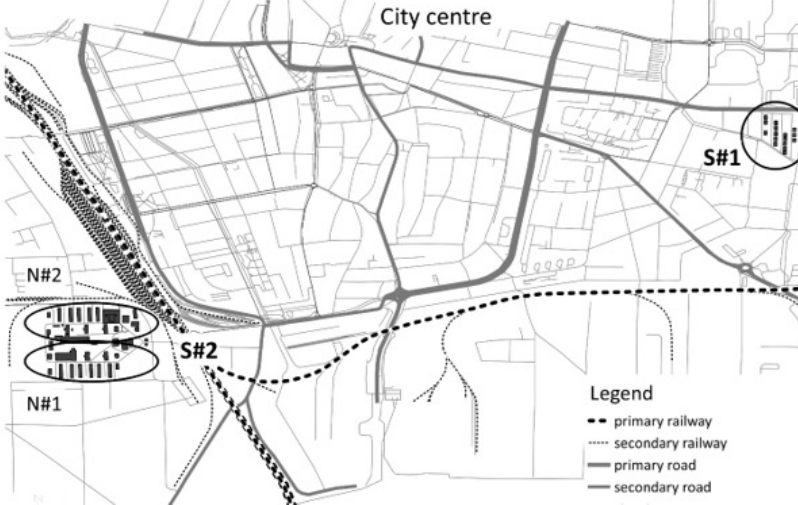
Figure 1. Segregated areas (S#1 and S#2) and different neighbourhoods (N#1 and N#2) within